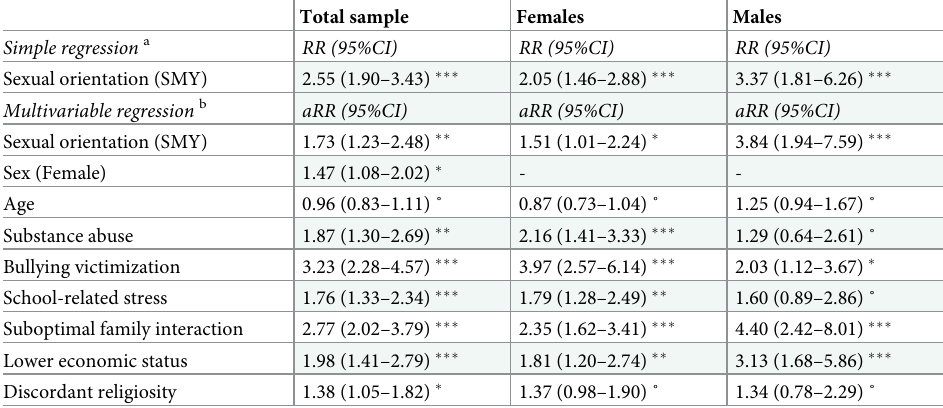
Table 3. Sexual orientation and persistent serious suicidal ideation during the